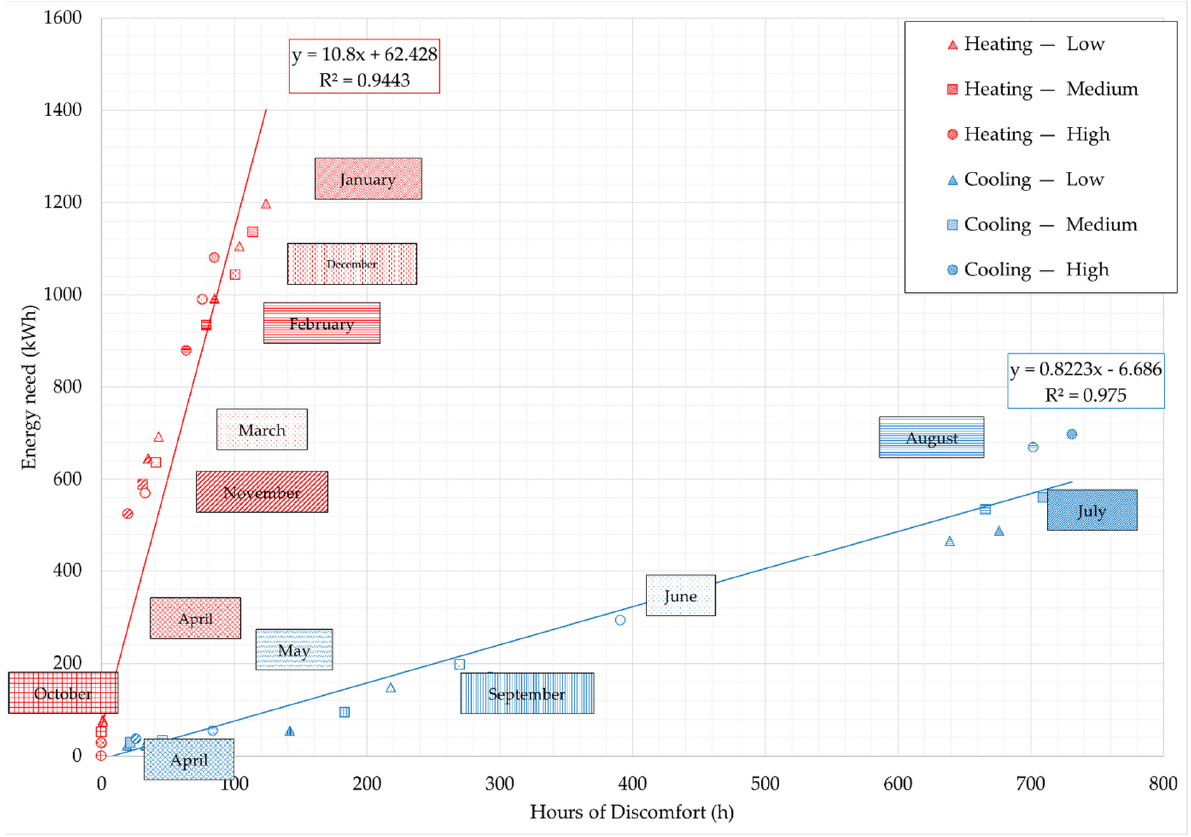
Figure 13. Energy needs for heating and for cooling compared to the hours of discomfort for the three scenarios.